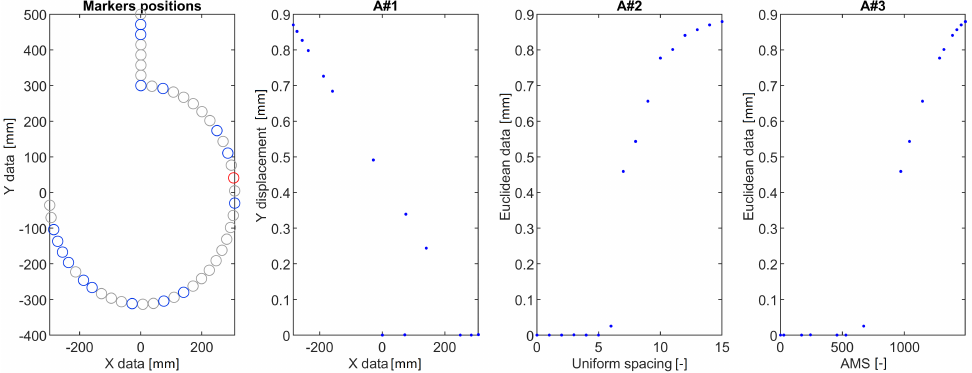
Figure 3. DDs for a curved beam structure calculated using the three tested approaches. Blue circles denote points used for evaluation. Grey circles denote points randomly excluded from measurement. The red circle denotes the damage location.